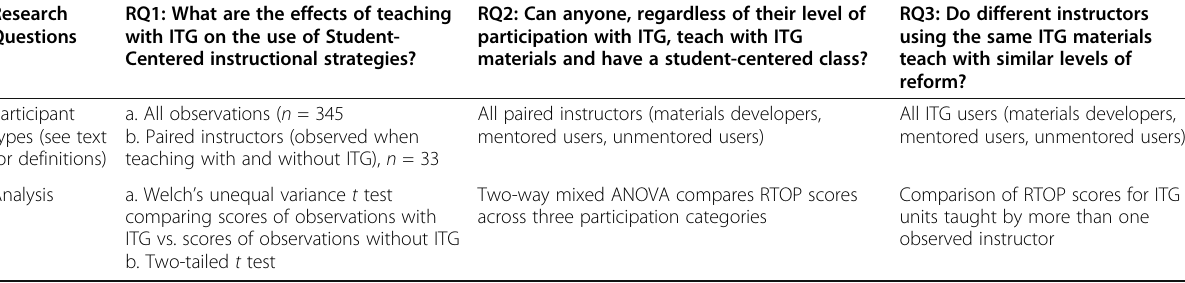
Table 2 Organization of this project ’ s research questions and participation by 287 observed instructors Research